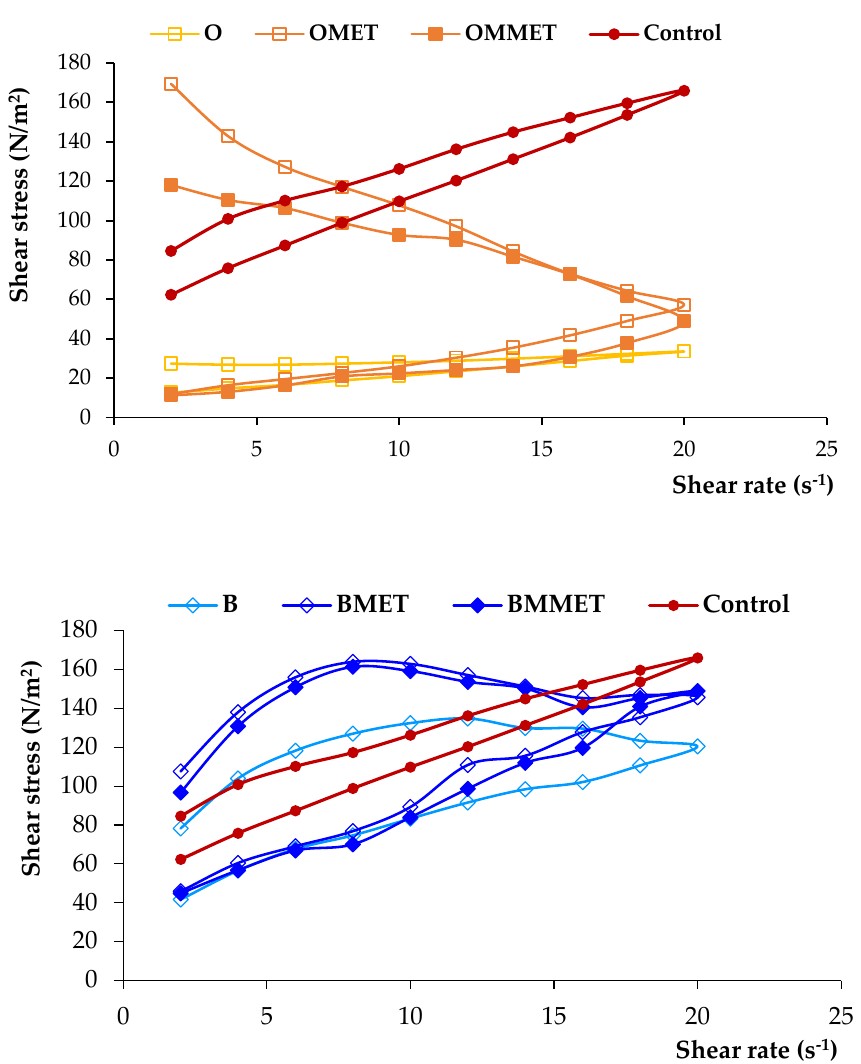
Figure 3. Rheograms of hydrogels, oleogels and bigels containing MET (HMET, OMET, BMET) or MMET (HMMET, OMMET, BMMET), placebo gels (H, O, B) and commercially available product (C).